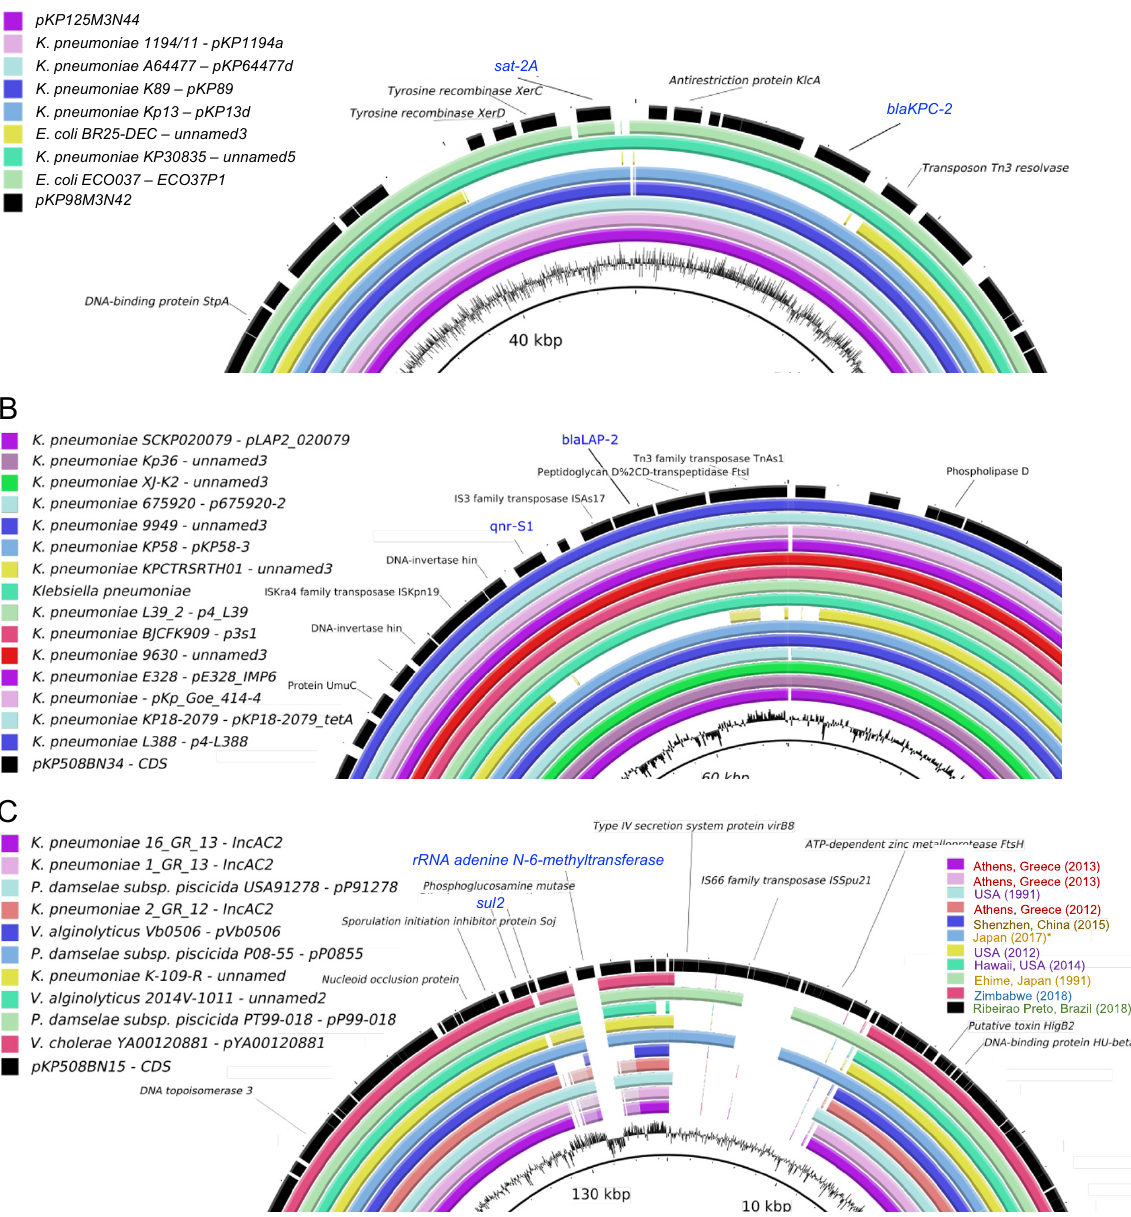
Figure 8. Structural comparison of plasmids from K. pneumoniae strains. Identified plasmids were analyzed using blast, and the best hits were used for comparison using BLAST Ring Image Generator (BRIG) [66]. For simplification, only divergent regions between the plasmids are shown. ( A ) pKP98M3N42 (black) and pKP1253N44 (magenta). ( B ) pKP508BN34 (black). ( C ) pKP508BN15 (black).